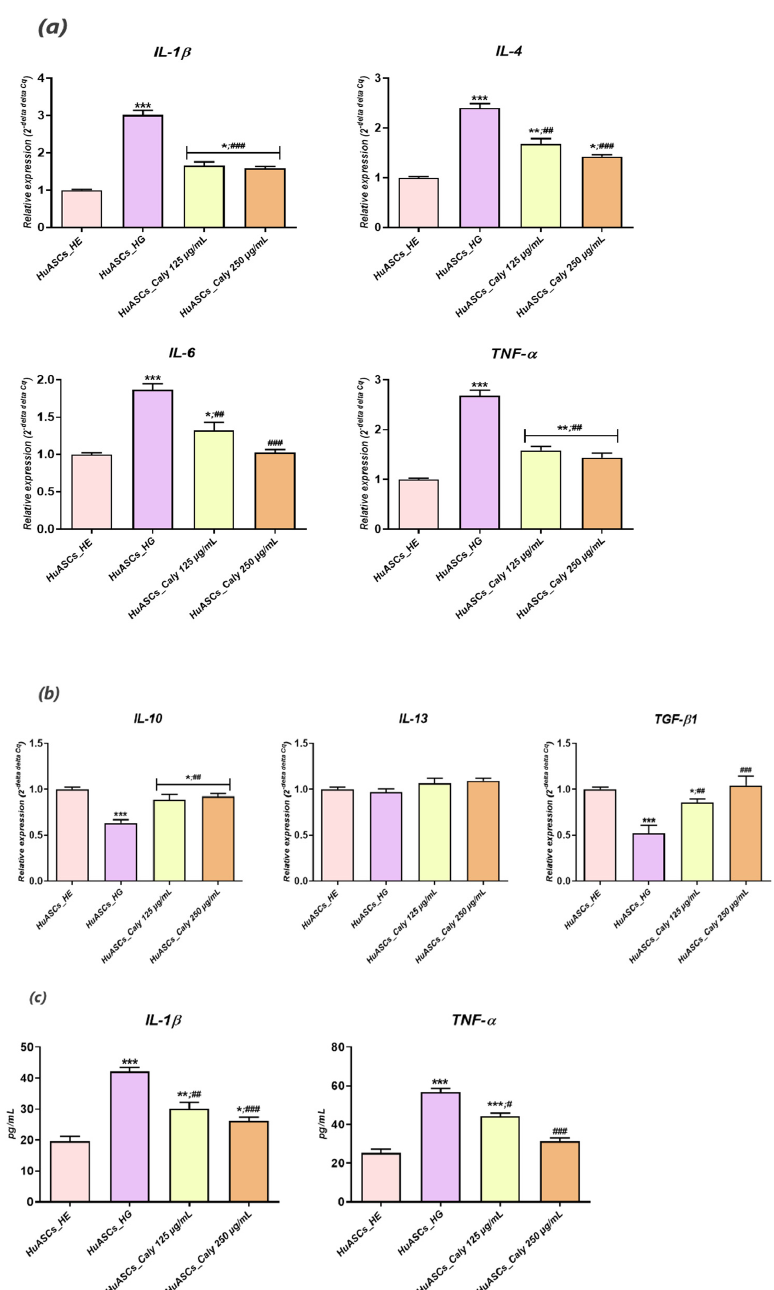
Figure 7. Reducing effect of total calystegine extract on hyperglycemia-mediated inflammatory response in HuASCs cells. ( a ) Histograms summarising the relative gene expression of key pro-inflammatory cytokines. ( b ) Representation of normalized gene expression of main anti-inflammatory markers. ( c ) ELISA quantification results of IL-1 β and TNF- α proteins levels. Representative data from three independent experiments are shown ± SD (n = 3). An asterisk (*) indicates a comparison of the HG group to the untreated healthy cells. A hashtag (#) indicates a comparison of HG group pre-treated with calystegines to HG untreated healthy cells. */# p < 0.05, **/## p < 0.01, ***/### p < 0.001. HuASCs_HE: human ASCs healthy untreated cells; HuASCs_HG: hyperglycaemic human ASCs cells exposed to a high concentration of glucose. HuASCs_Caly 125 µg/mL: hyperglycaemic human ASCs cells pre-treated with 125 µg/mL calystegines extracted and exposed to a high concentration of glucose. HuASCs_Caly 250 µg/mL: hyperglycaemic human ASCs cells pre-treated with 250 µg/mL calystegines extracted and exposed to a high concentration of glucose.